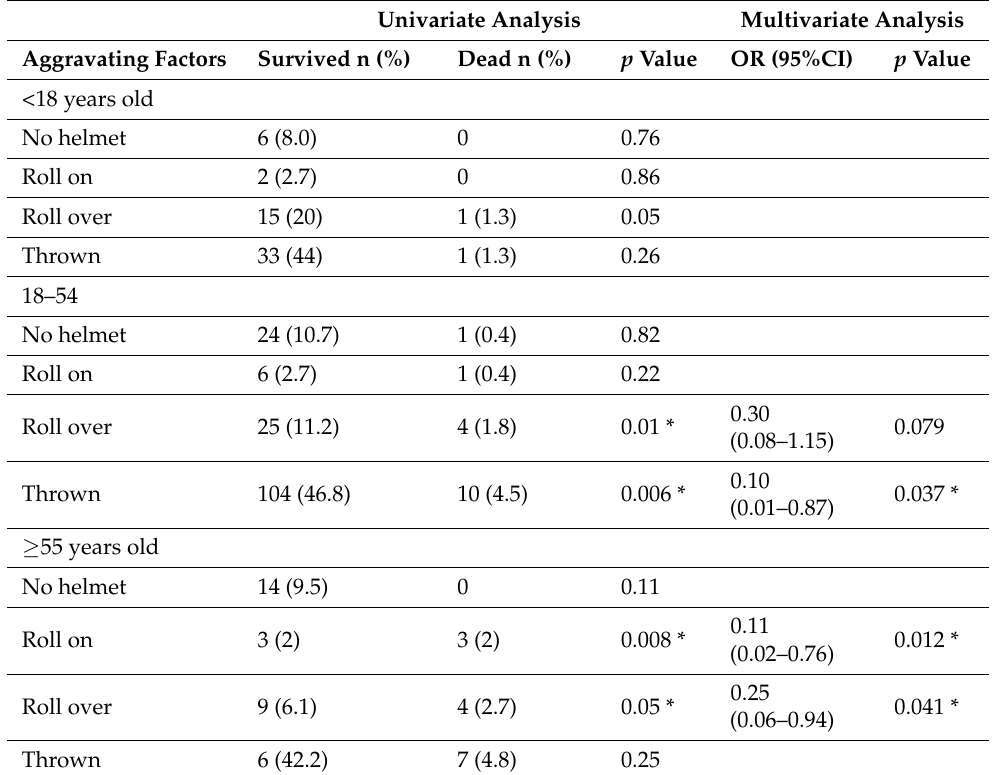
Table 3. Aggravating factors according to outcome.